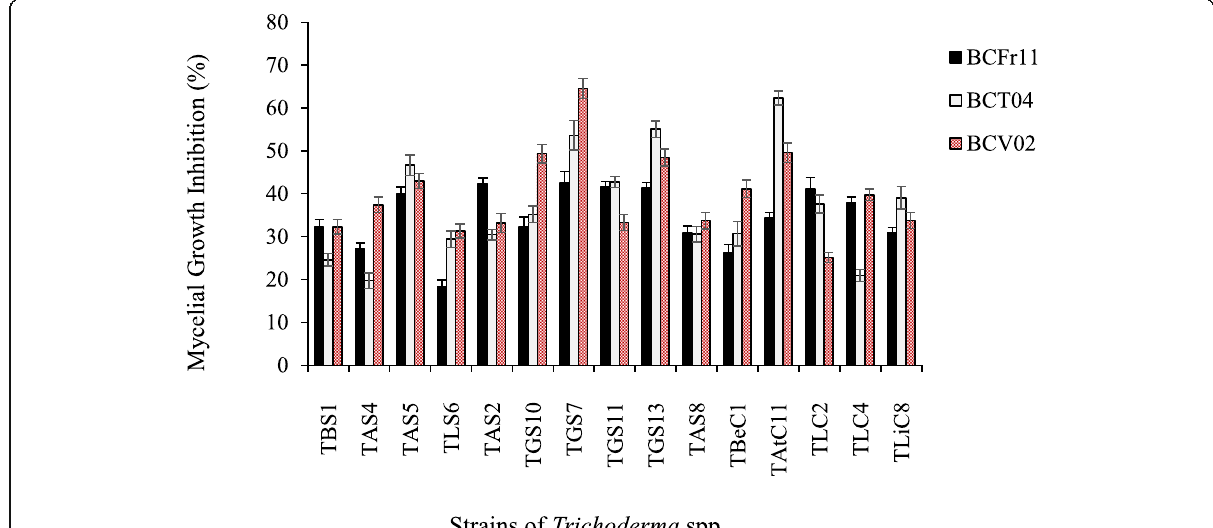
Fig. 4 Mycelial growth inhibition of three isolates of B. cinerea caused by volatile compounds produced by 15 isolates of Trichoderma spp. Values are the mean of technical and biological replicates